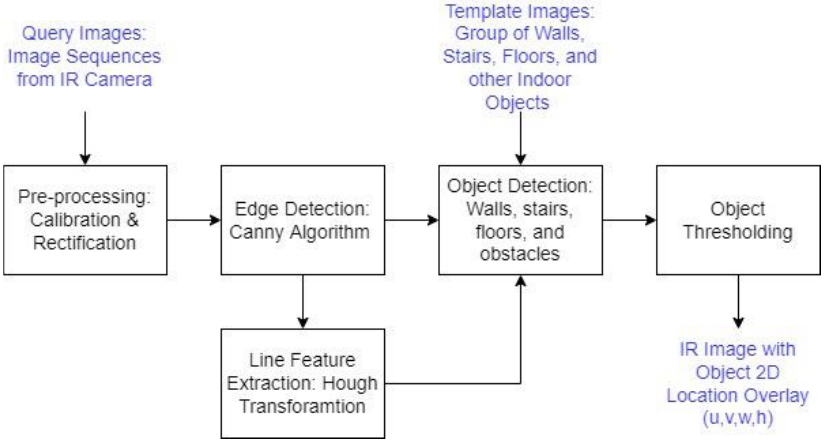
Figure 6. Overview of thermal IR image processing ( u , v , w , h : positions at x and y axis, width, and height of an object, respectively).